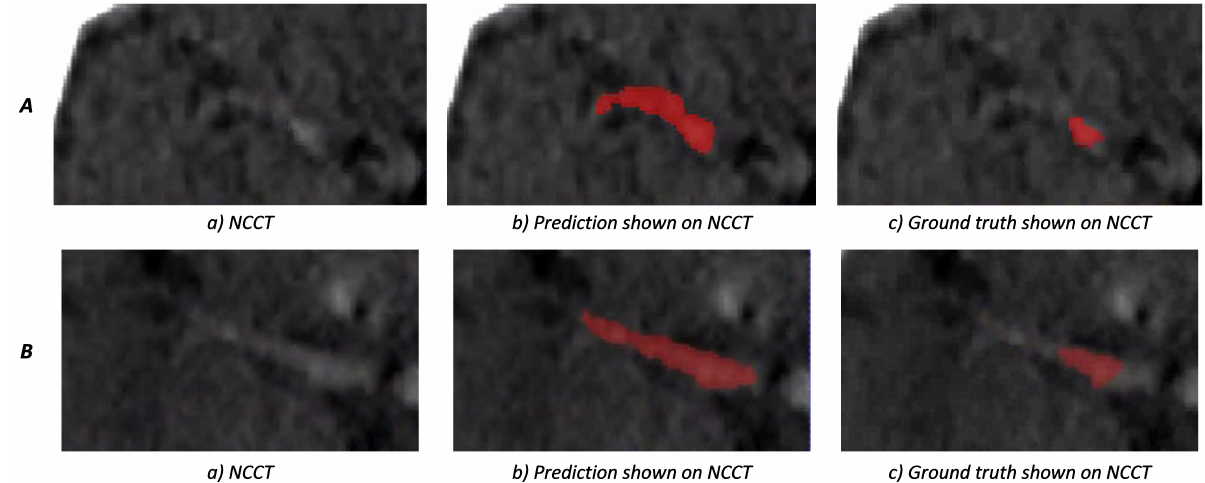
Figure 8. A and B both show cases where weighted-sum predictions only partially agree with the ground truth. In figures ( b , c ), the prediction and ground truth are shown in red, respectively. In cases where the thrombus intensity decays gradually, it can be difficult to determine the extent of the thrombus, manually and